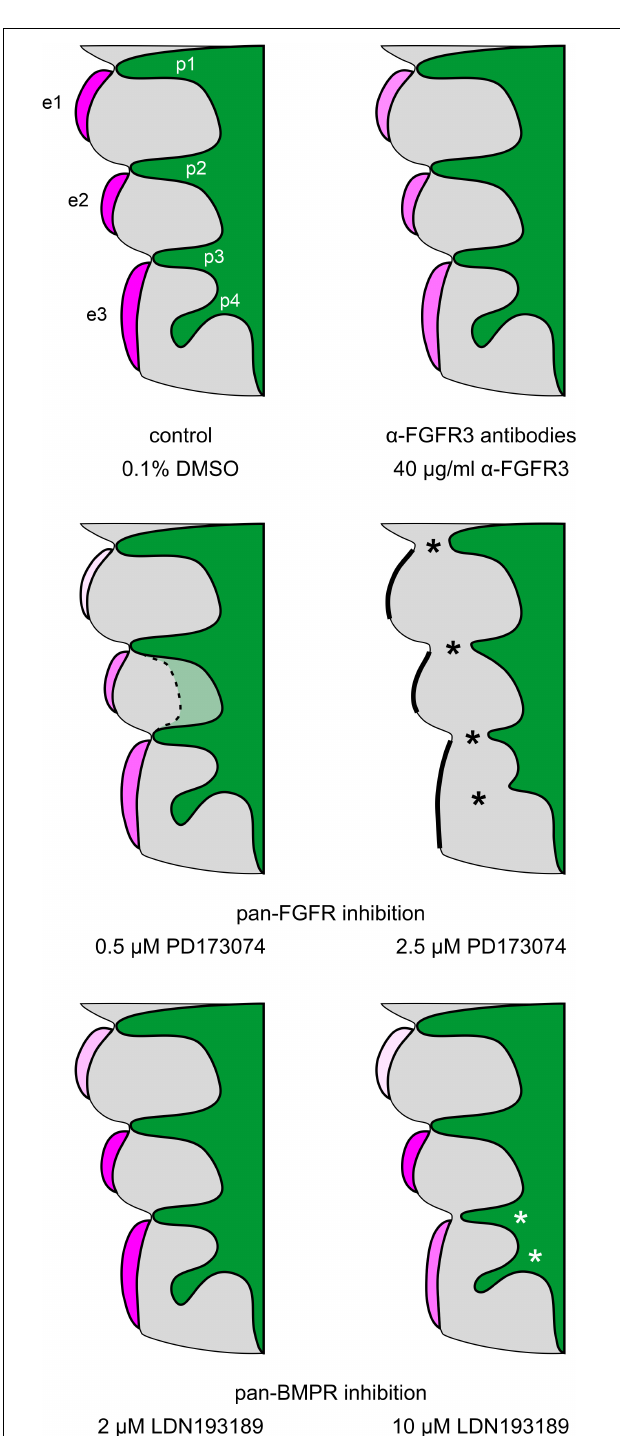
FIGURE 6 | Summary scheme: Impact of FGFR and BMPR inhibition on epibranchial placode morphogenesis and neurogenesis in 9–14 somite mouse embryos, cultured for 24 h. e1, e2, e3, epibranchial placodes 1, 2, and 3; p1, p2, p3, p4, pharyngeal pouches 1, 2, 3, and 4; green, endoderm; gray, branchial arches. Increasing intensities of purple color indicate increasing numbers of Neurogenin2 + epibranchial neuroblasts. Different degrees